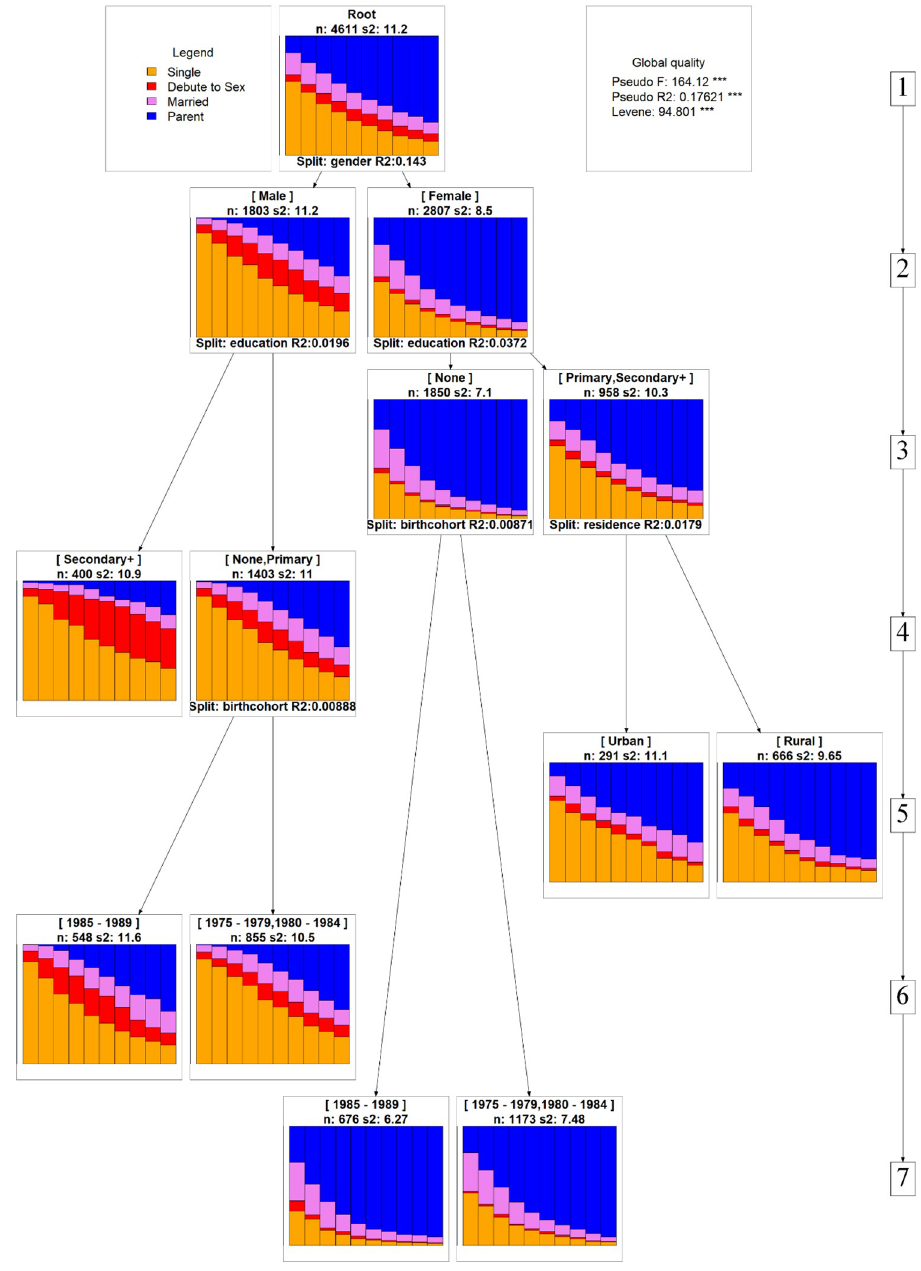
Fig 3. Sequence regression tree,